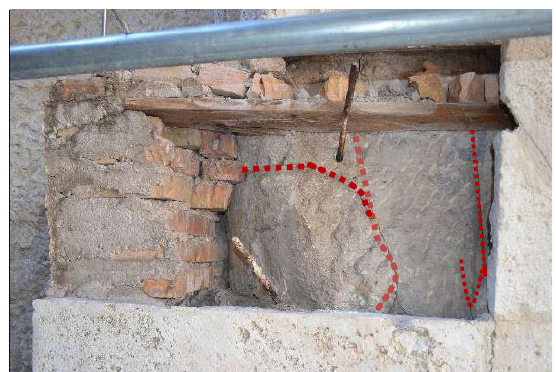
Figure 21. Cracks detected and highlighted in red on the columns of the first floors after removing the travertine slabs in pillar 5. Figure 23. a) Cement cap of the post tensioned cable positioned on the top of column 3 with crack highlighted in red; b.) Post tensioned cable after removing the cement